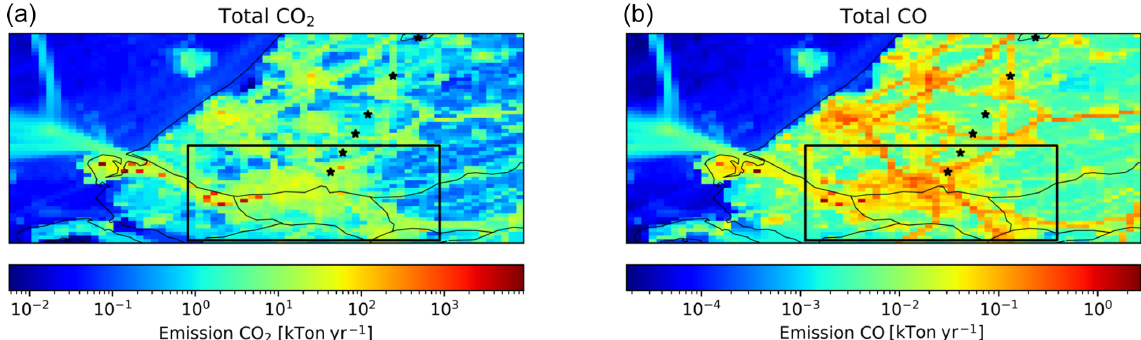
Figure 6. Emissions of CO 2 (a) and CO (b) for part of the Netherlands, including the subdomain (black rectangle) over Rotterdam. Black stars indicate the receptor